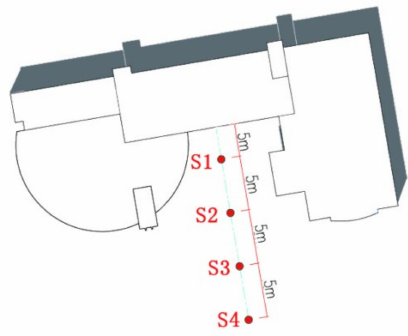
Figure 17. Setting of the measuring points near the building thermal interface.